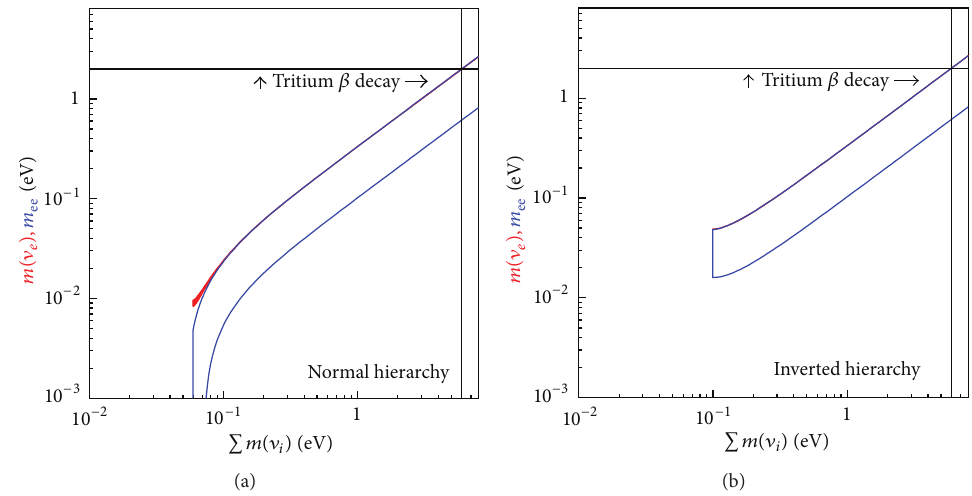
(open blue band) and of direct neutrino mass determination by single 𝛽 -decay ee ) for the case of normal hierarchy (a) and of inverted 𝑖